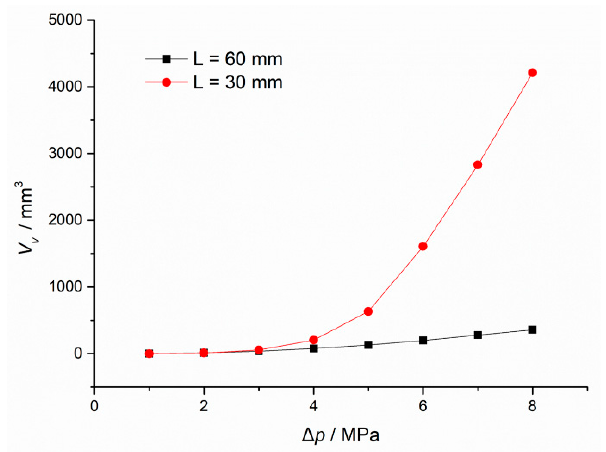
Figure 13. Total vapor volumes inside the valve for different pressure differences with the valve core displacement of 60 mm and 30 mm.